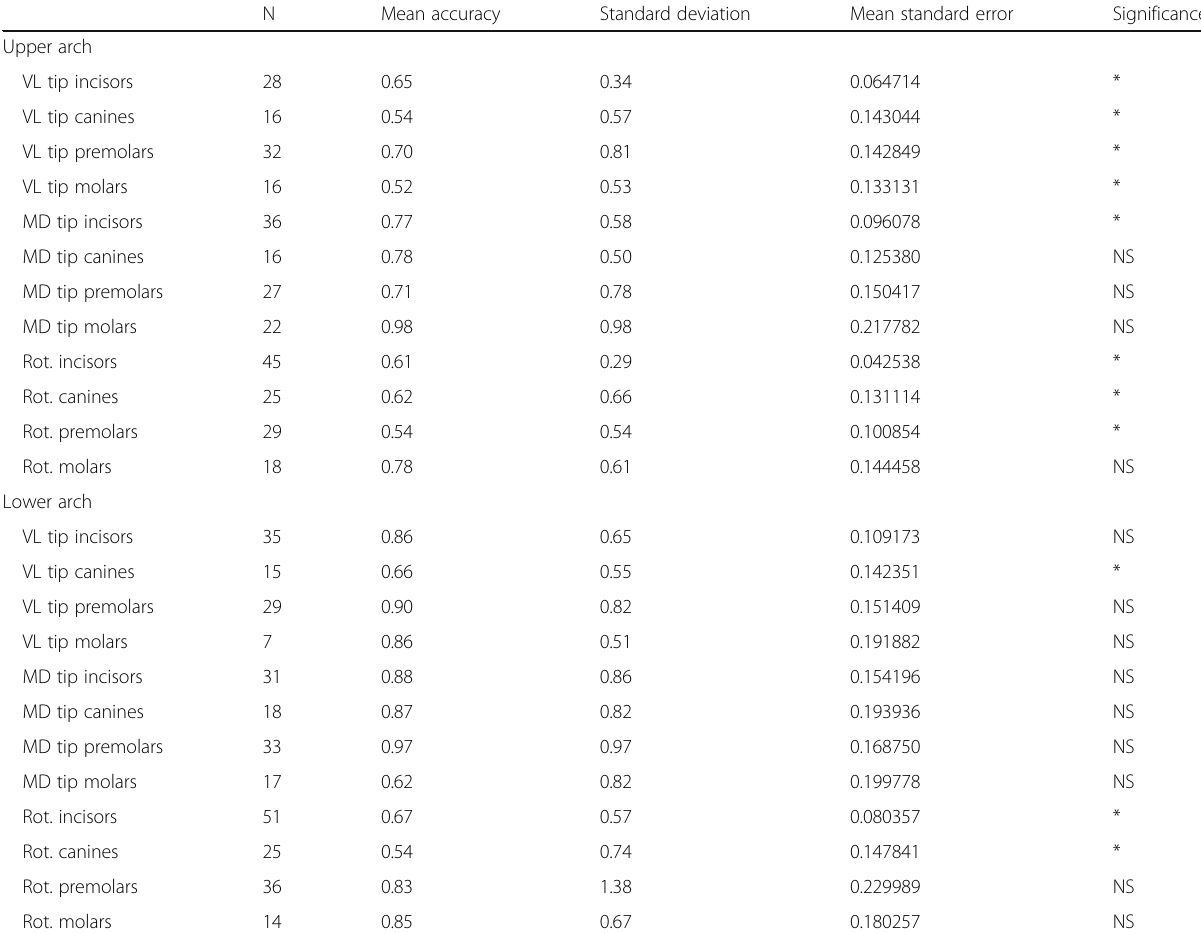
Table 4 Accuracy of movements achieved N Mean accuracy Standard deviation Mean standard error Significance